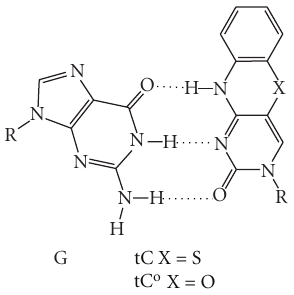
Figure 11: Fluorescent cytosine analogs tC and tC ◦ form canonical base pairs with dG, do not perturb B-form DNA structure, and can pair with a FRET donor to probe DNA polymerase dynamics [144– 146, 149,